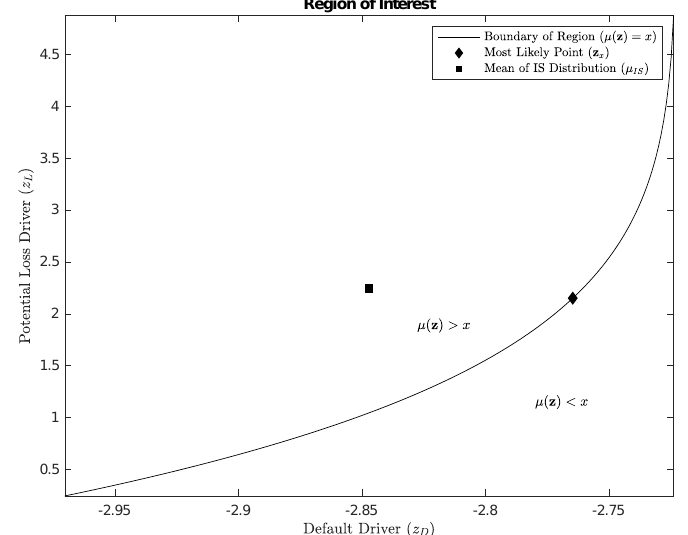
interest. Parameters (randomly selected using the procedure in Section 5.3) in both panels are ( P , ρ ) = (0.0063, 0.3964, 0.2794, -0.3356, -0.7599, 0.6497, 0.5033, 134) and the threshold D , ρ L , ρ I , ρ S , a , b , N is x = 0.1575. Mean losses are E [ L i ] =